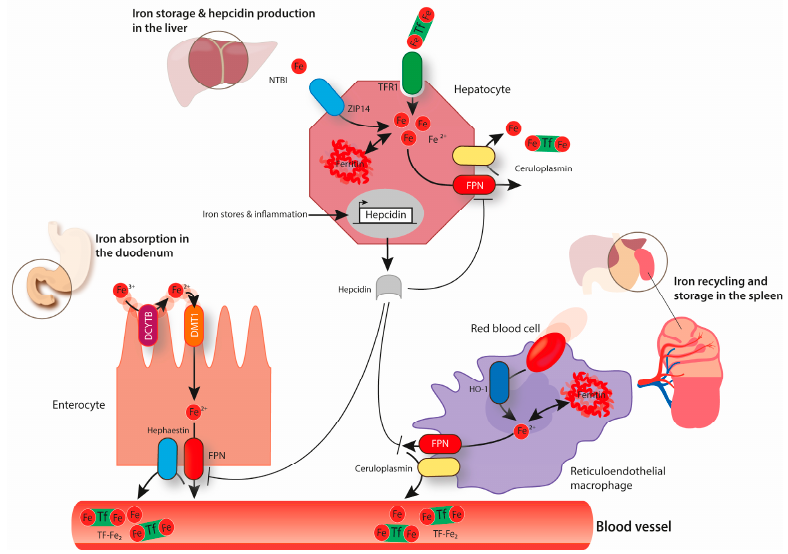
Figure 1. The above image represents systemic iron homeostasis. Dietary iron absorption occurs at the brush-border membrane of duodenal enterocytes. Ferric iron (Fe 3+ ) is reduced to ferrous iron (Fe2 + ) by duodenal cytochrome B (DCYTB) and is transported across the membrane via divalent metal transporter 1 (DMT1). The export of iron through the basolateral membrane of enterocytes occurs via ferroportin (FPN) and is coupled to the reoxidation of Fe 2+ to Fe 3+ , a process that is catalyzed by hephaestin. Ferric iron circulates in the blood bound to transferrin (Tf-Fe 2 ). Transferrin-bound iron can be taken up via transferrin receptor 1 (TfR1) by every cell type in the organism, including hepatocytes that store high amounts of iron in ferritin. Hepatocytes can also take up non-transferrin-bound iron (NTBI) via ZRT/IRT-like protein (ZIP14). When required, iron can be exported from hepatocytes via FPN back to circulation (a process combined with the re-oxidation of Fe 2+ to Fe 3+ mediated by ceruloplasmin). Senescent erythrocytes are engulfed by reticuloendothelial macrophages. Iron is released from heme by heme oxygenase (HO1) and it can be either stored in ferritin or exported back to the circulation, depending on systemic iron requirements. Iron export from macrophages via FPN is also coupled to the activity of ceruloplasmin. Hepcidin produced by hepatocytes has the ability to decrease cellular iron export by binding to FPN and inducing its endocytosis and degradation. The expression of hepcidin is controlled by several factors including body iron stores and